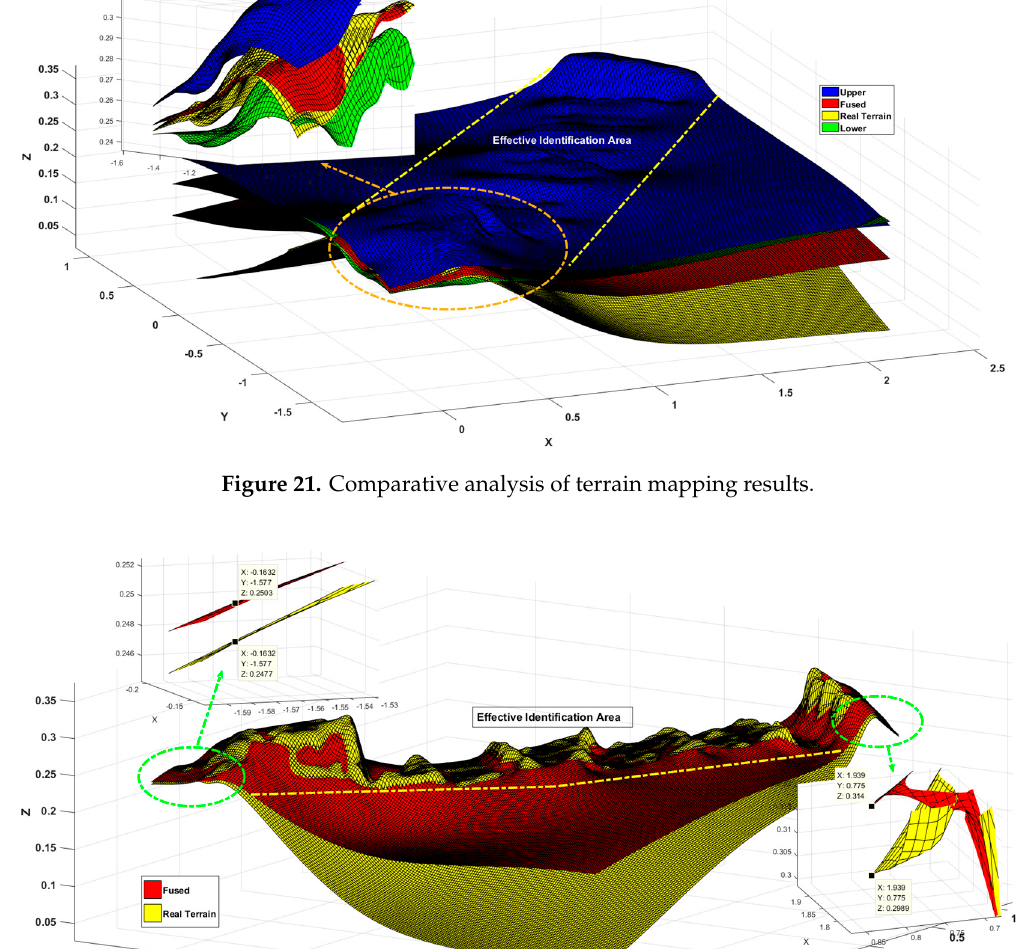
Figure 22. Comparative analysis of terrain estimates and real